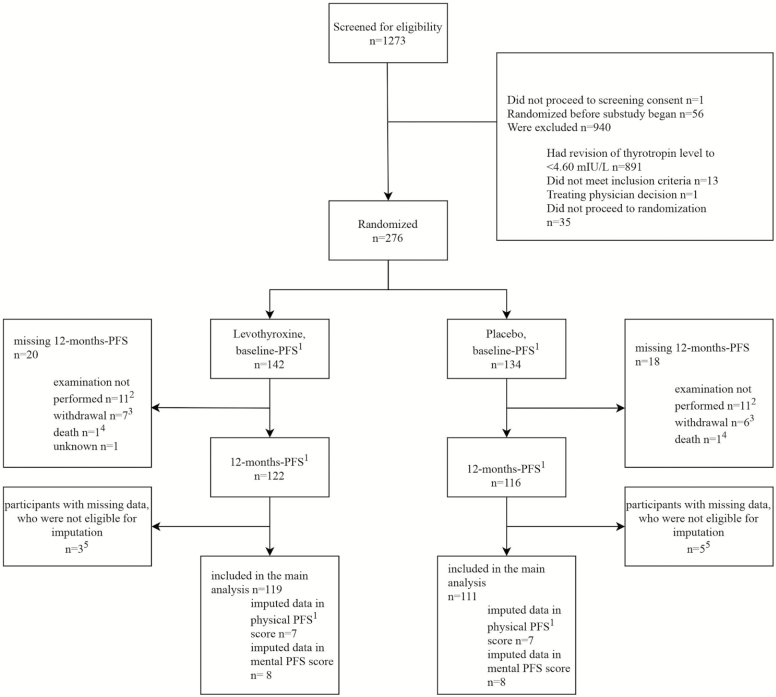
Randomization and follow-up. 1The Pittsburgh Fatigability Scale (PFS) has two separate subscores for mental and physical fatigability, each ranging from 0 to 50 with higher scores indicating greater fatigability. 2Eleven participants in the levothyroxine group and 11 participants in the placebo group had a follow-up visit but did not answer the PFS-questions due to administrative reasons, n = 1 participant in the placebo group had a follow-up visit but did not answer the PFS-questions due to unknown reasons. These missing outcomes were accounted for in sensitivity analysis (Inverse probability weighting [IPW] analysis). 3Thirteen participants withdrew, in eight cases due to participants’ decision, in three cases due to adverse events, in one case due to physician recommendation for unknown reason and in one participant the reason is unknown. 4One participant died from a septic shock due to a colon perforation combined with a segmental pulmonary embolism left and one participant died from dehydration due to an aspiration pneumonia with acute hypoxemia and progression of cell carcinoma of the hypopharynx. Both deaths were not related to the medication. 5Participants with more than three missing questions or lacking information whether the activity has been done or not for a missing answer, as defined in the rules to analyze PFS (13,18).